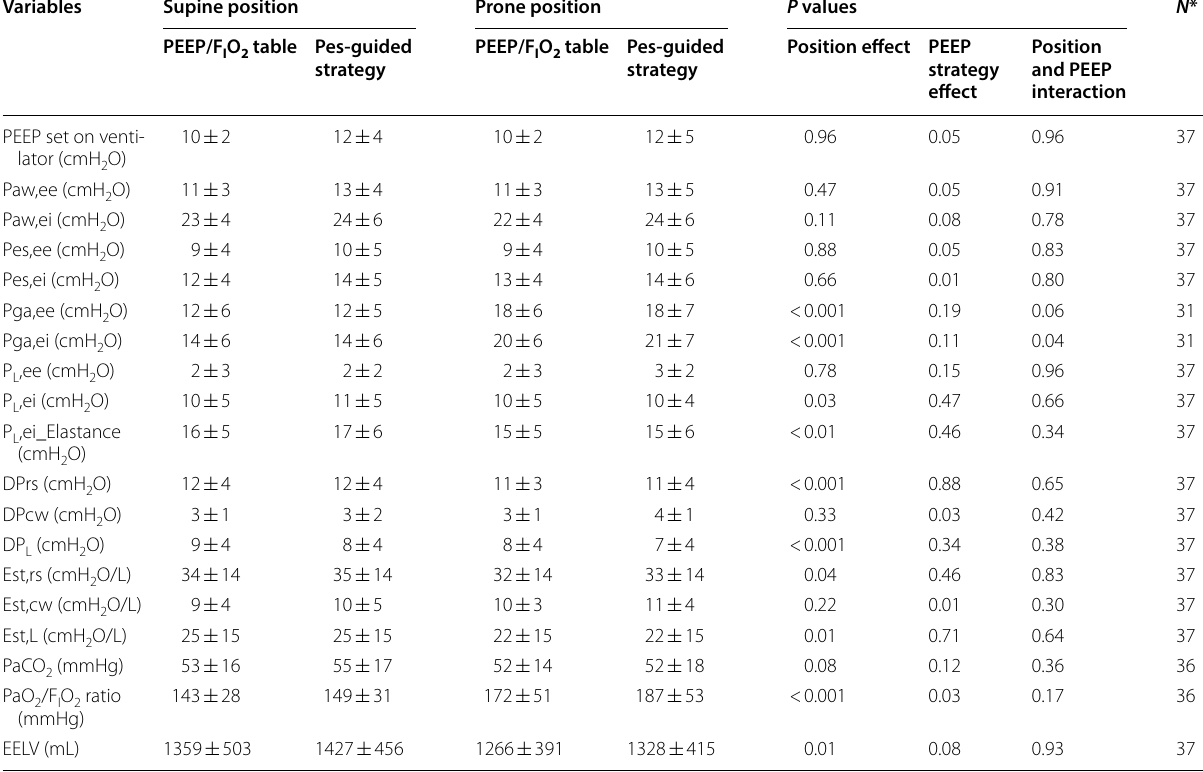
Values are mean